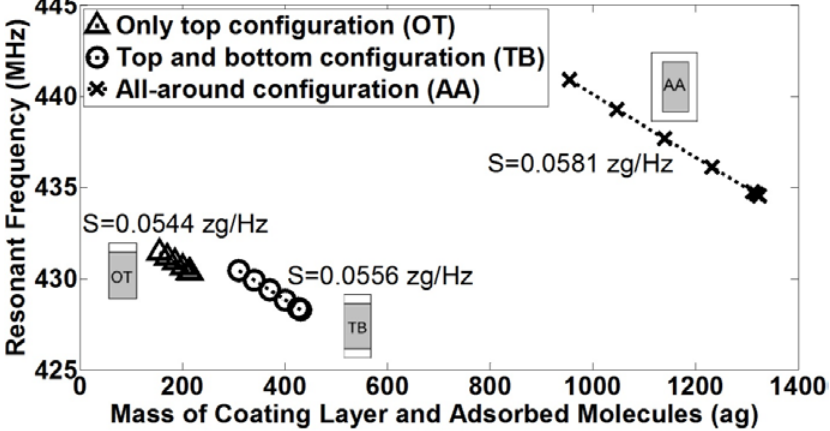
Figure 8. The resonant frequency versus mass of coating layer and adsorbed molecules of top and bottom (TB), only top (OT) and all-around (AA) configurations for the detection process in